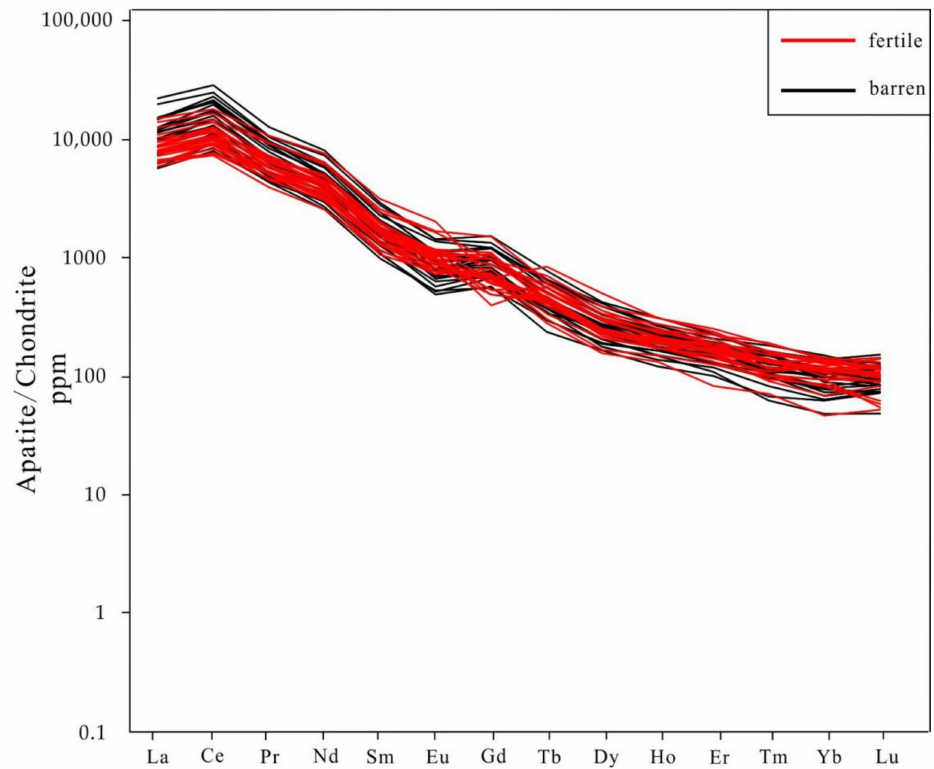
Figure 5. Apatite REE patterns of samples from the Yao’an gold deposit [67]. The chondrite-normalized patterns are depleted in HREE and enriched in LREE and are characterized by positive Ce anomalies with negative Eu